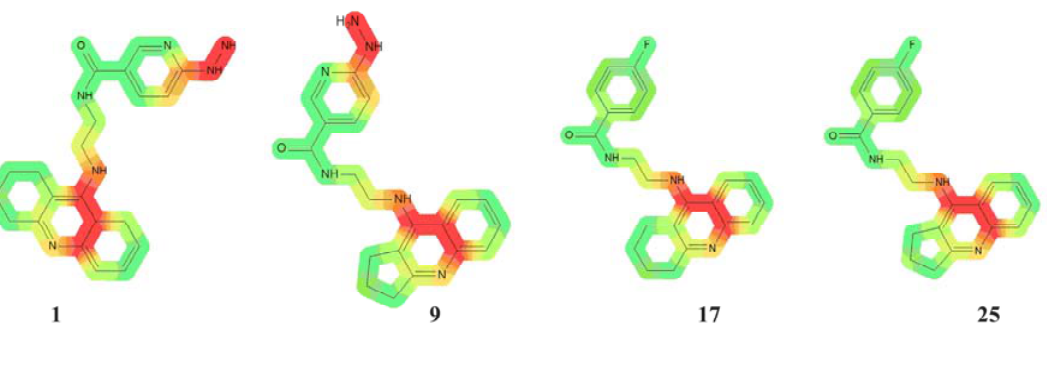
Figure 4. Different “hazardous” substructures were identified. Compounds with two carbon atoms in the chain from every group are